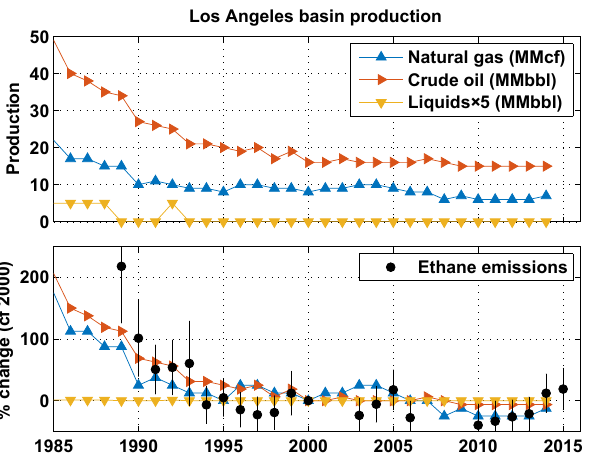
Figure 5. The left-hand axis shows methane emissions measured in the atmosphere by three TCCON FTS instruments that were located in the SoCAB since 2007. The grey solid line indicates the best- fit slope with standard errors indicated by the grey dashed lines. Previous measured emissions are indicated by green squares. The right-hand axis shows the delivered natural gas to the SoCAB and is scaled such that if 2% of the delivered gas is released into the atmosphere, the atmospheric burden would be equal to the numbers (in Gg) on the left-hand axis.